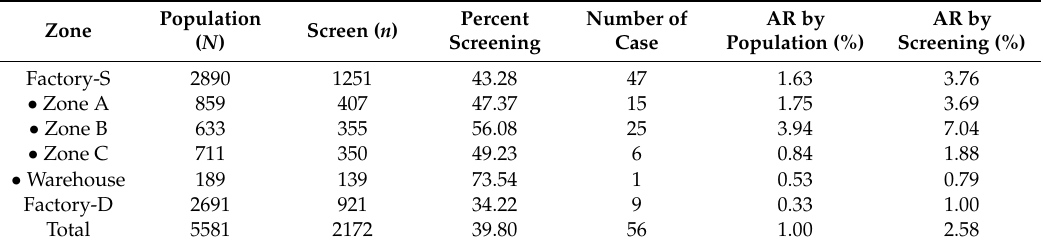
Table 1. Number of total population, cases, and attack rate by working zones in Factory-S and Factory-D